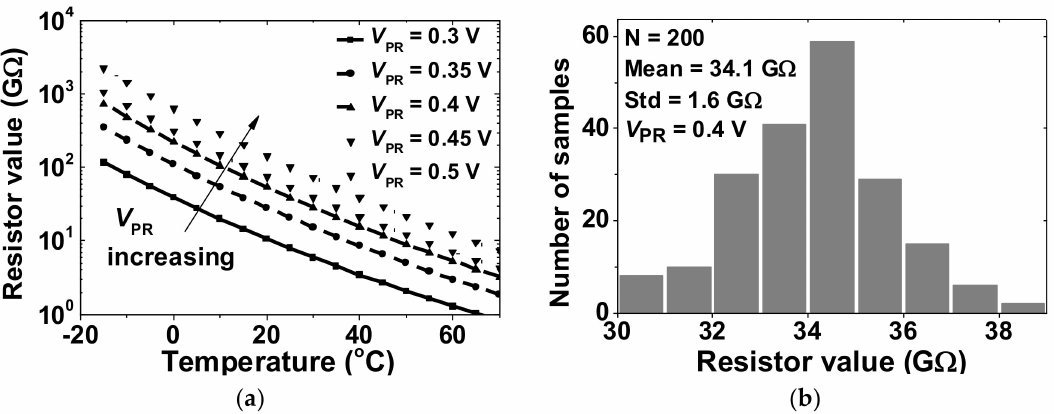
Figure 8. ( a ) simulated value of the pseudo-resistor as a function of temperature for various V PR and ( b ) Monte Carlo simulation result of the pseudo resistor value at V PR = 0.4 V.